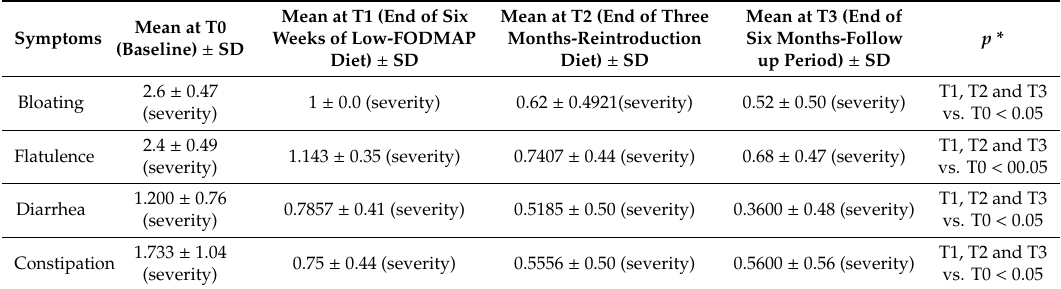
Table 5. Severity of analyzed symptoms at T0, T1, T2, and